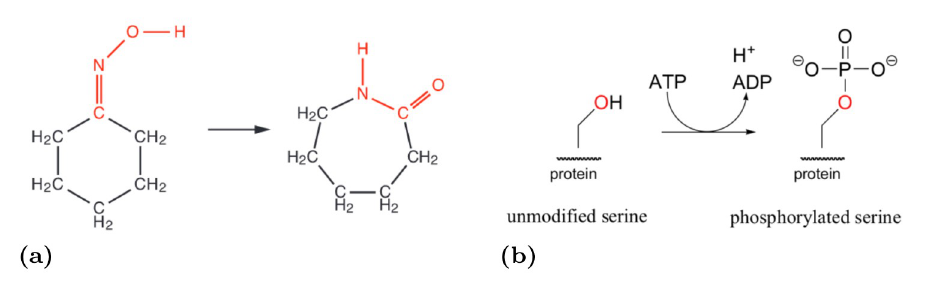
Fig 1. Examples of chemical reactions. (A) An example of elemental chemical reaction. The description of interacting species is given on molecular level, providing exact specification of how the species is transformed. (B) An example of general chemical reaction. A protein is being phosphorylated on a serine residue. The particular interaction is described in detail (which does not generally hold for this type of reactions) but the molecular details of the entire species is abstracted, since the focus is put only on the interaction